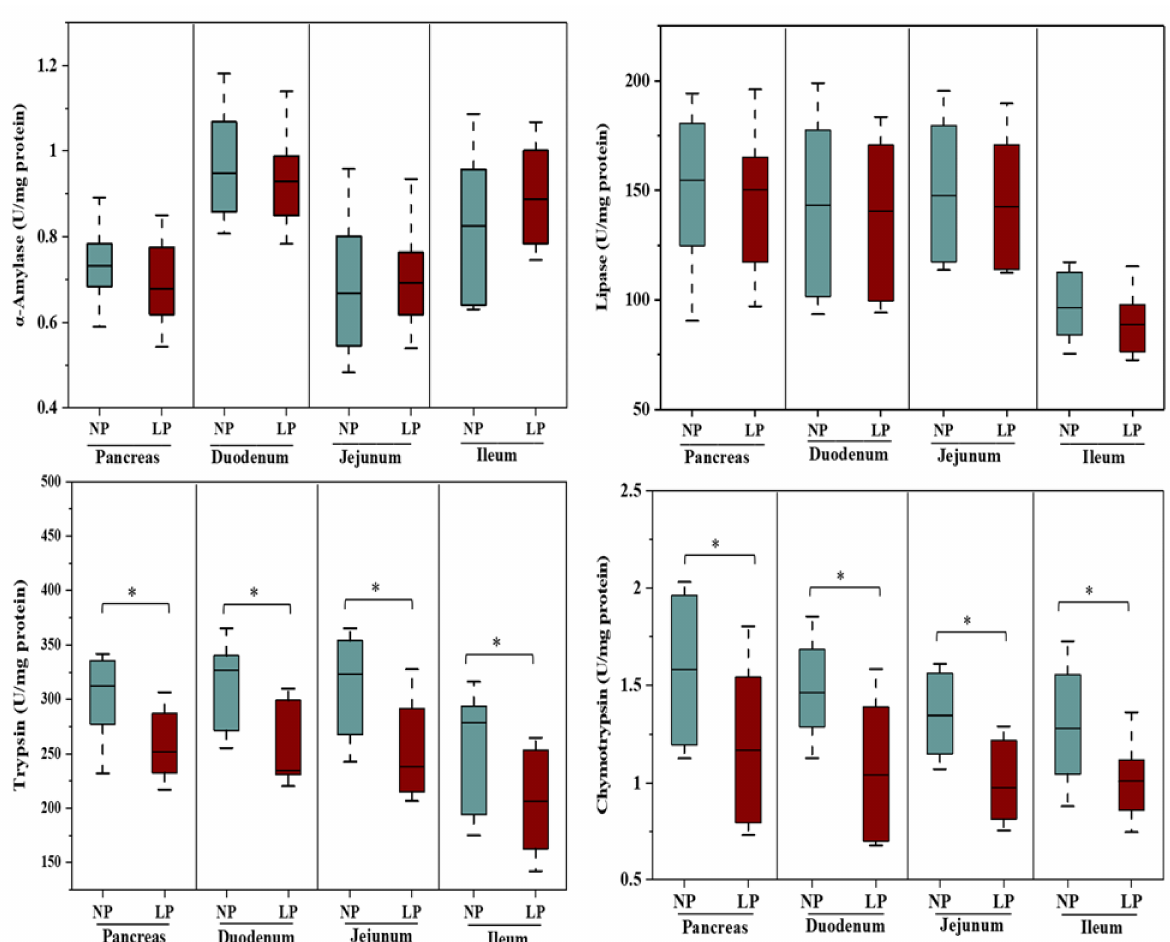
Figure 1. Pancreas and small intestine α -amylase, lipase, trypsin and chymotrypsin activities in goats fed a low-protein diet. The results are presented as the mean ± SE; * = p < 0.05. NP = a control protein diet; LP = a low-protein